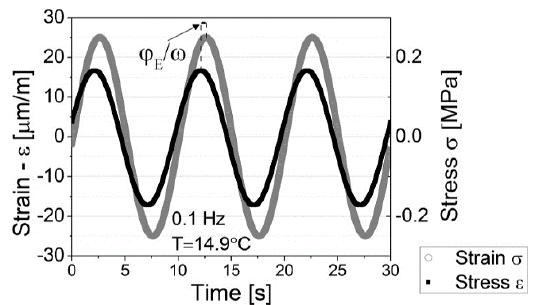
Figure 2. Example of stress and strain signals – Complex modulus test on the GB5  mixture (gap-graded) (f = 0.1Hz and T = 14.9